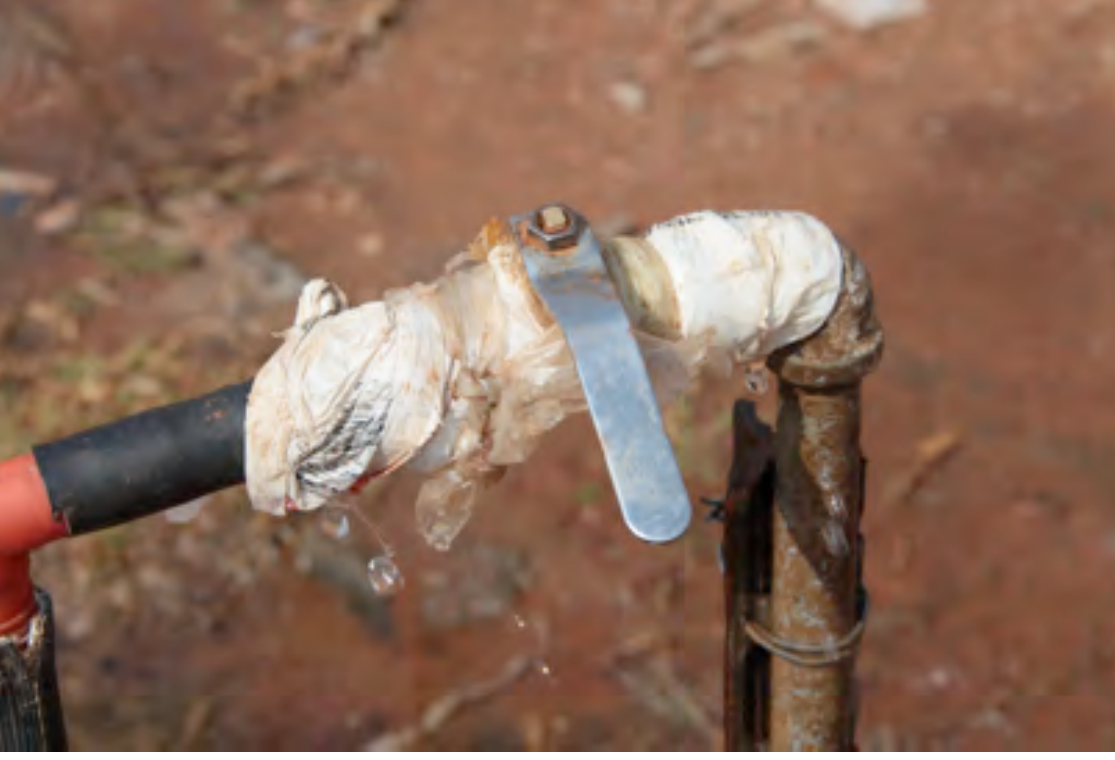
Figure 5 Some resident use plastic bags to stop tap leaks (Photograph: JWN